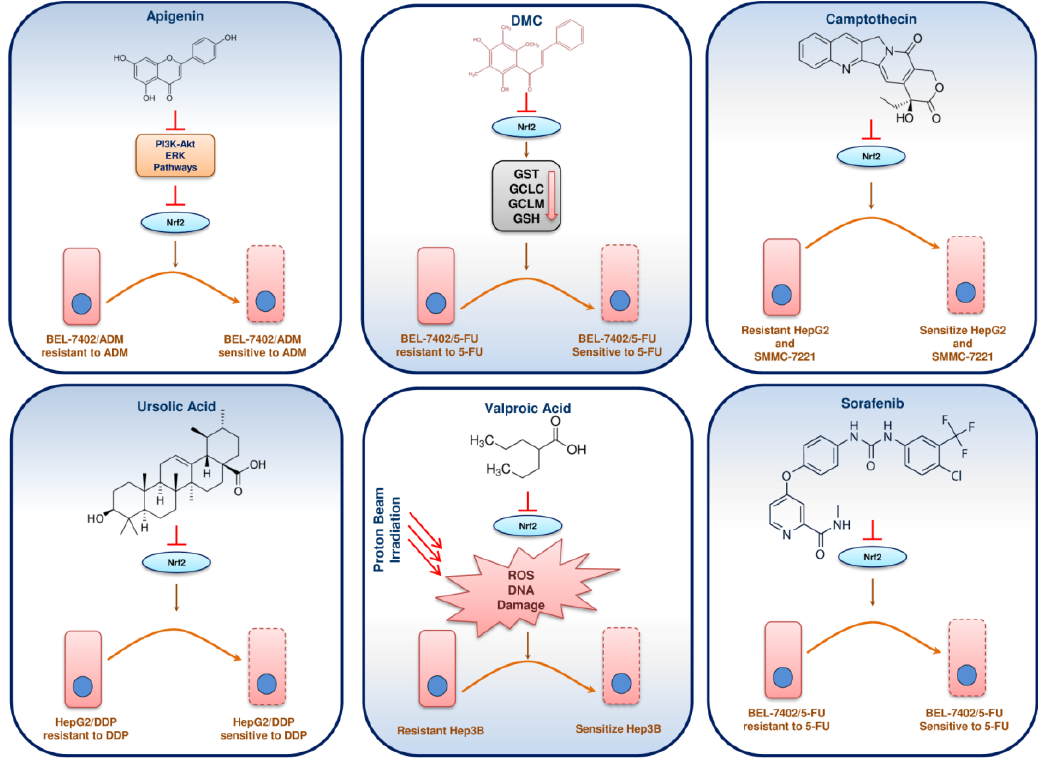
Figure 6. Phytochemicals/molecules that inhibit Nrf2, leading to the sensitization of drug resistant HCC.